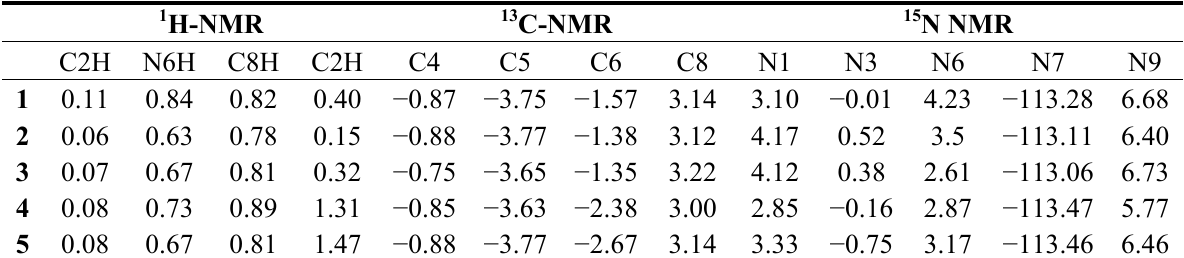
Table 1. The 1 H, 13 C and 15 N NMR coordination shifts ( Δδ = δ adenine moiety atoms of the prepared complexes.